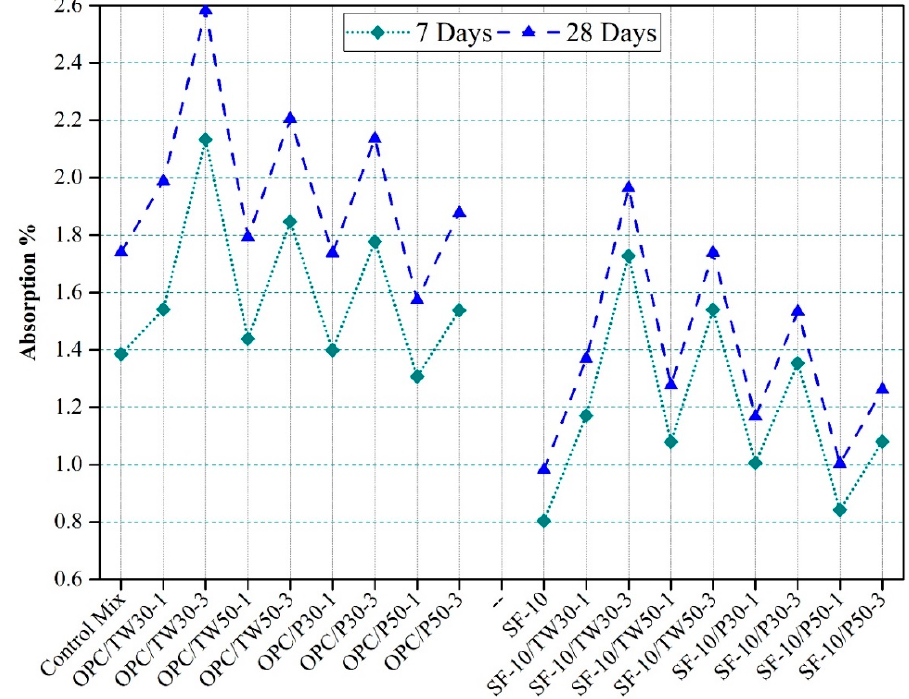
Figure 10. Densities of specimens made with tea waste and perlite particles with OPC and SF as binders.